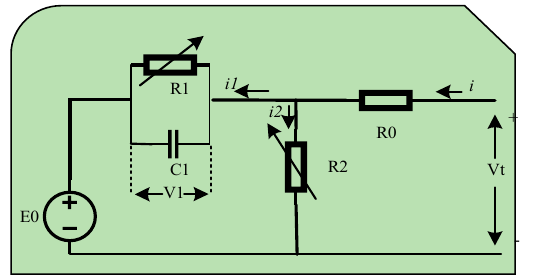
Figure 5. One branch ECM model for SOC estimation of supercapacitor.